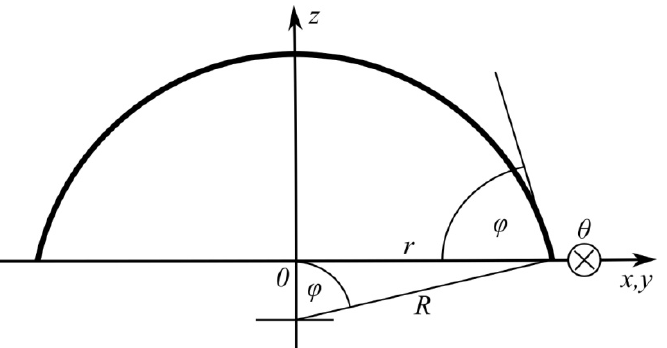
Figure 1. Adopted coordinate system and designations of the geometrical dimensions of the drop being a sphere segment. The symbol marked θ shows the direction of the axis of an angular variable in a cylindrical coordinate system, perpendicular to the drawing plane.